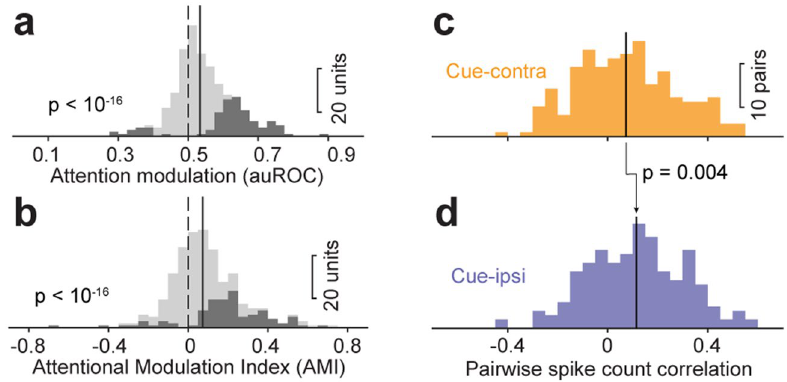
Figure 2. Population summary of cue-related modulation on mouse SC firing rate and interneuronal spike- count correlations. ( a ) Distribution of delay period activity auROC comparing cue-contra and cue-ipsi trials; bin width of histograms is 0.05. Dark bars count units with auROC value significant different from chance level (bootstrapped 95% CI ⊄ 0.5). Dashed line indicates chance value of 0.5, solid line indicates population median (0.53). ( b ) Distribution of delay-period AMIs between contralaterally and ipsilaterally cued trials, using the same conventions as in ( a ). Dark bars count units with significant AMI ( p < 0.05, rank sum test of spike count between cue-ipsi and cue-contra trials). Dashed line indicates chance value of 0, solid line indicates population median (0.07). ( c ) Distribution of delay period interneuronal spike-count correlations during “cue-contra” trials of simultaneously recorded SC neuronal pairs. Solid line: population median. ( d ) Distribution of delay period spike-count correlations during “cue-ipsi” trials. Solid line: population median. P value is from paired-sample Wilcoxon signed-rank test comparing population medians between “cue-contra” and “cue-ipsi”